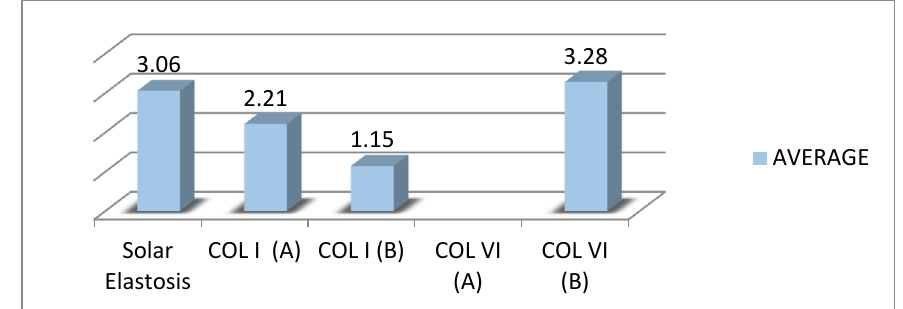
Figure 3. The average expression of COL I and COL VI relative to the degree of solar elastosis.